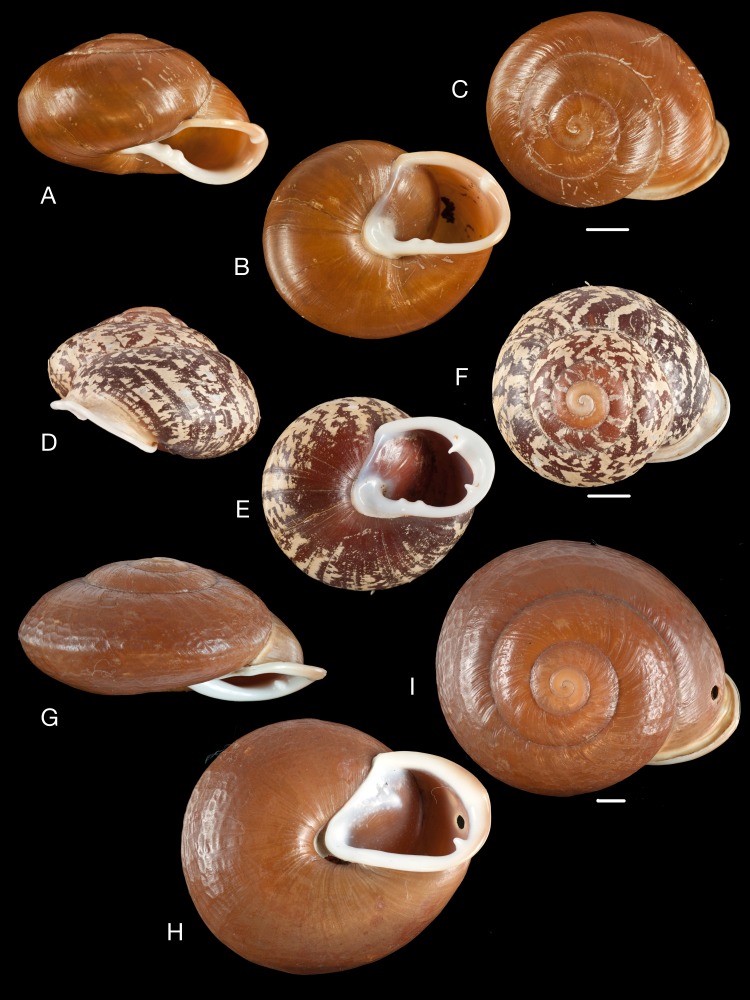
Material collected by the CCP.(A–I) Pleurodontidae. Isomeria bituberculata (Pfeiffer, 1853), MNCN 15.05/58506, (A) ventral view, (B) umbilical view, (C) apical view; Isomeria bourcieri (Pfeiffer, 1853), MNCN 15.05/58504, (D) lateral view (lip), (E) umbilical view, (F) apical view; Isomeria cymatodes (Pfeiffer, 1852), MNCN 15.05/58506, (G) ventral view, (H) umbilical view, (I) apical view. Scale line 5 mm.